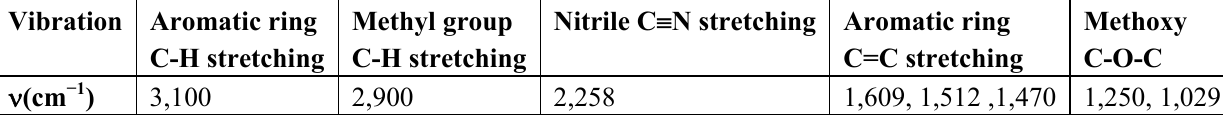
Table 1. Group frequency assignments for the main infrared bands observed in OMPA and OBMPA